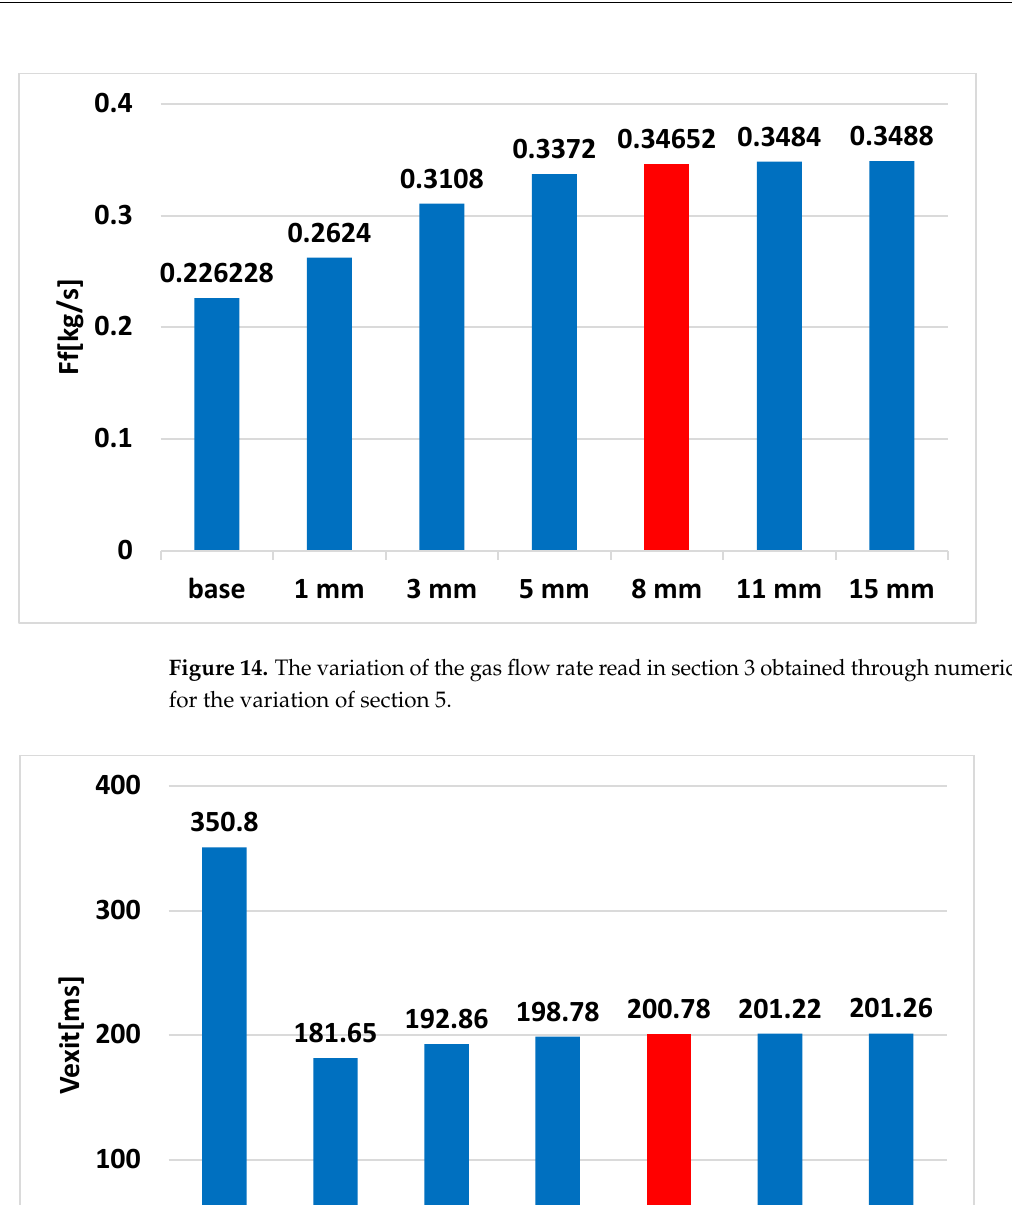
Figure 13. The variation of the propulsion force read in section 3 obtained through numerical sim- ulations for the variation of section 5.